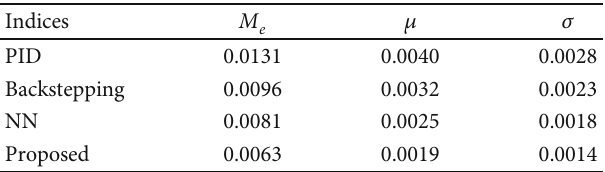
Figure 6: Tracking performance of square signal. Table 2: Performance indicators for square